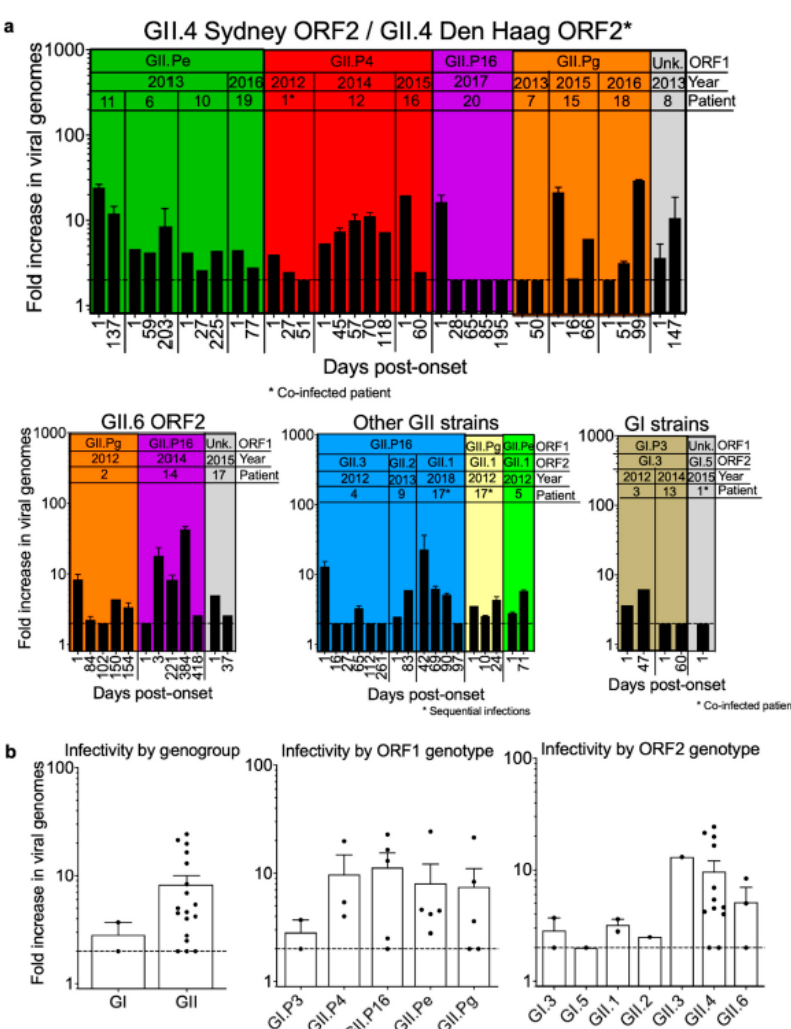
Figure 5. Infectious virus is consistently detected in fecal samples from chronically infected patients. ( a ) Levels of infectious virus detected in HEK293T cells inoculated with human norovirus genotypes, according to capsid ( ORF2 ) and polymerase ( ORF1 ) genotypes. The shaded boxes indicate samples with the same polymerase ( ORF1 ) genotype. Three patients (Patients 7, 12, and 1) did not have detectable infectious virus in any of the samples tested, and one patient did not have any after the initial sample collection. ( b ) Infectivity of different noroviruses subdivided by GI and GII genogroups and by different ORF1 and ORF2 genotypes. The dashed line represents the lower limit of detection. Error bars indicate SEM values. Data represent the averages from 2 independent experiments.